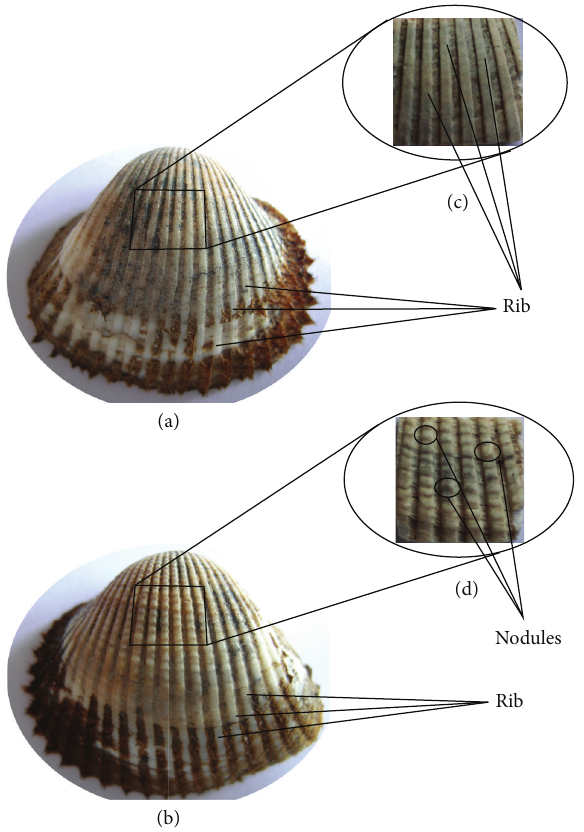
Figure 1: The morphology and structure of Scapharca subcrenata : (a) right shell; (b) left shell; (c) experimental sample illustrating rib morphology of right shell; and (d) experimental sample illustrating coupled structure of left